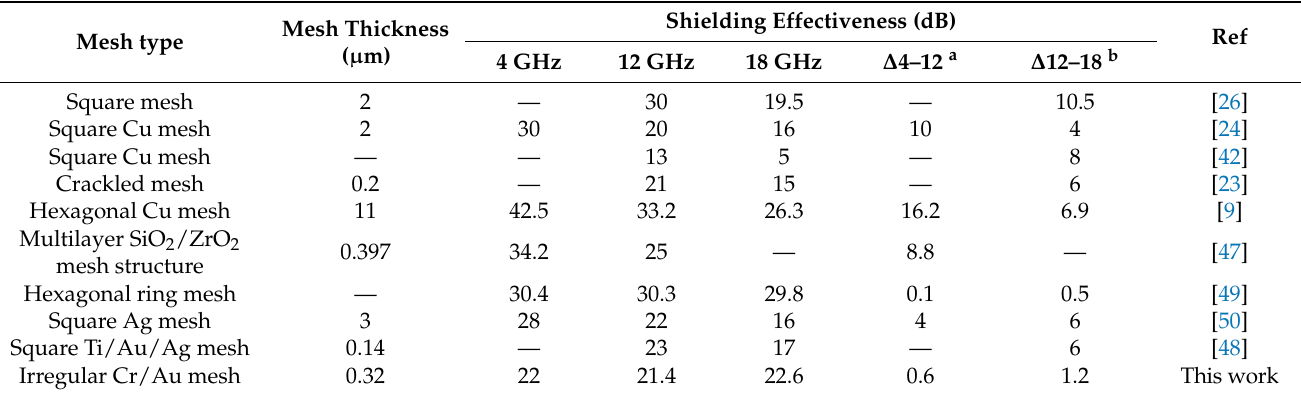
Table 2. Comparison of SE variation at different frequency for various mesh